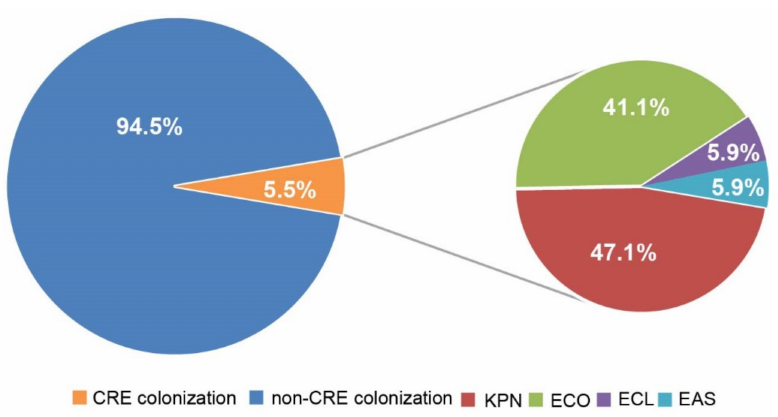
Figure 2. Distribution of the seventeen strains of CRE in ESLD patients.